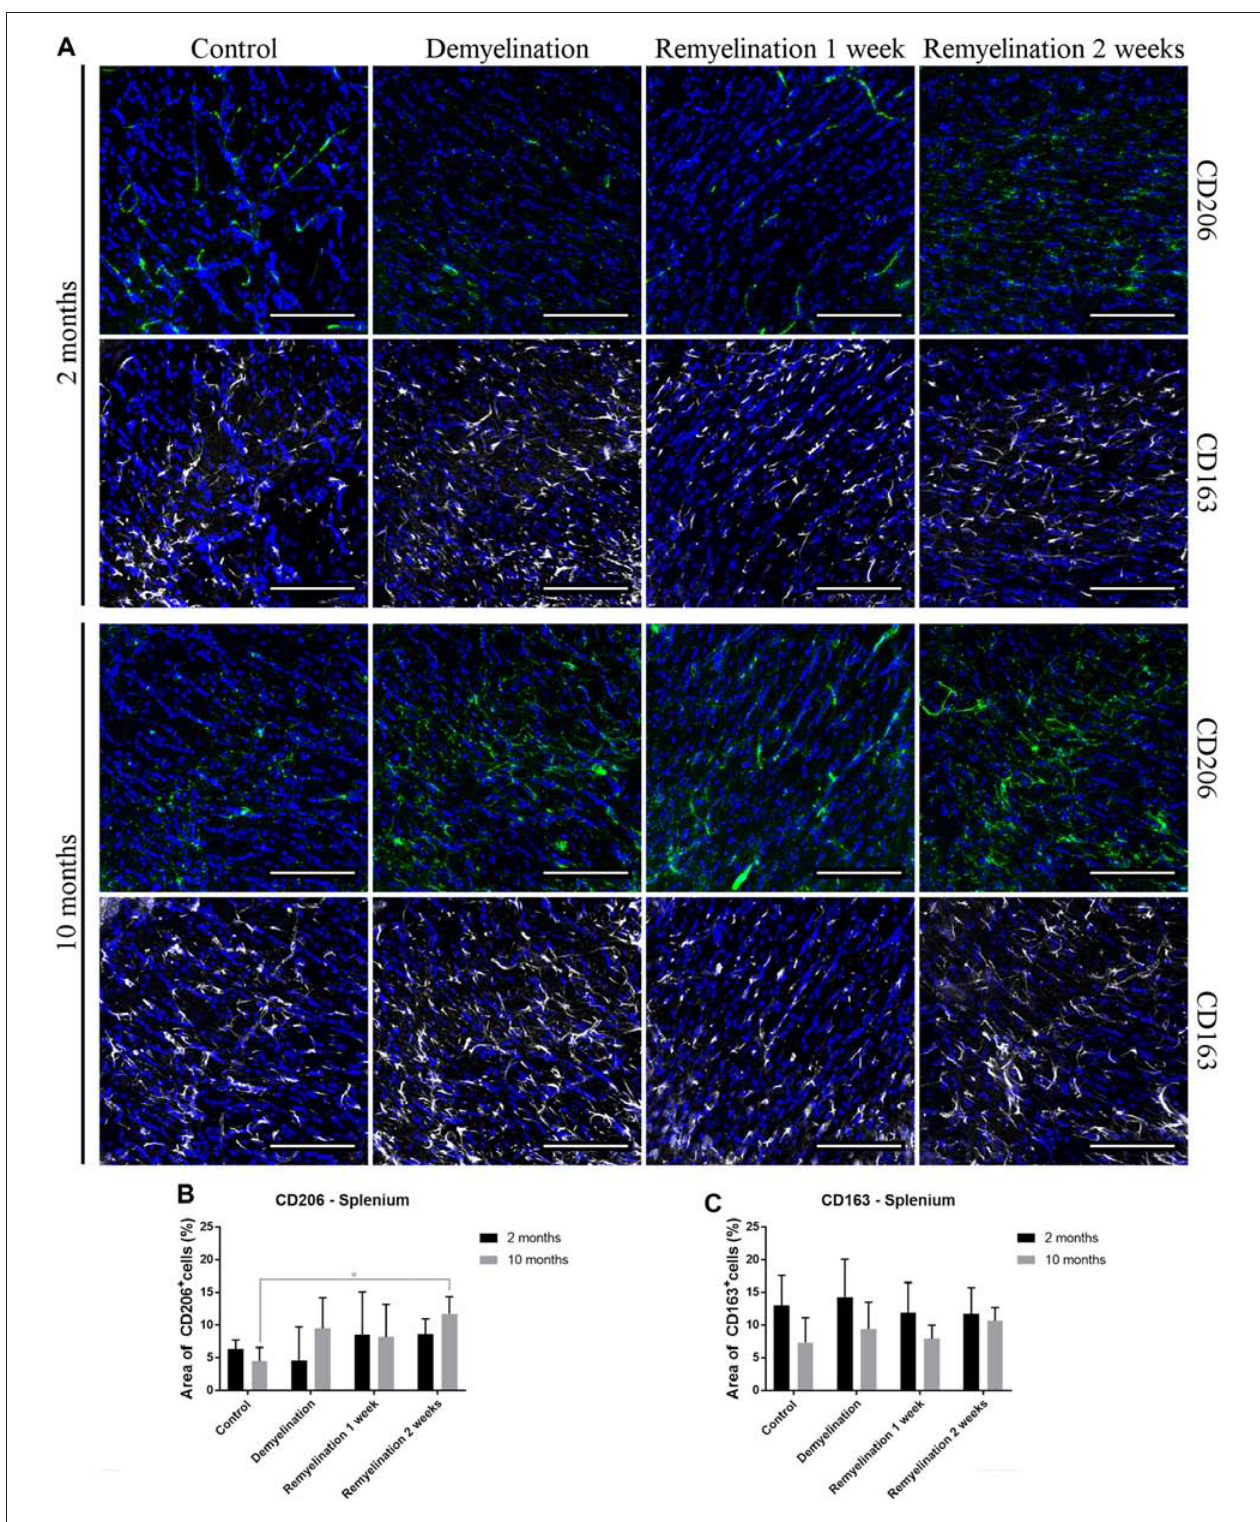
FIGURE 10 | Increase of CD206 during remyelination in middle-aged mice in the splenium of the CC, while CD163 is unaffected. (A) CD206 (green) and CD163 (white) labeling. Cell nuclei are stained with DAPI (blue). (B) CD206 was significantly elevated in the middle-aged group after 2 weeks of remyelination. (C) CD163 was not significantly affected by age or treatment. Values are shown as means + SD ( n = 6 per group). Statistical significance was evaluated using a two-way ANOVA followed by a Tukey’s post hoc test (C) . The p -values are indicated in the graphs: treatment effects within the same age group: ∗ p < 0.05. Bars: (A) 100 µ m.